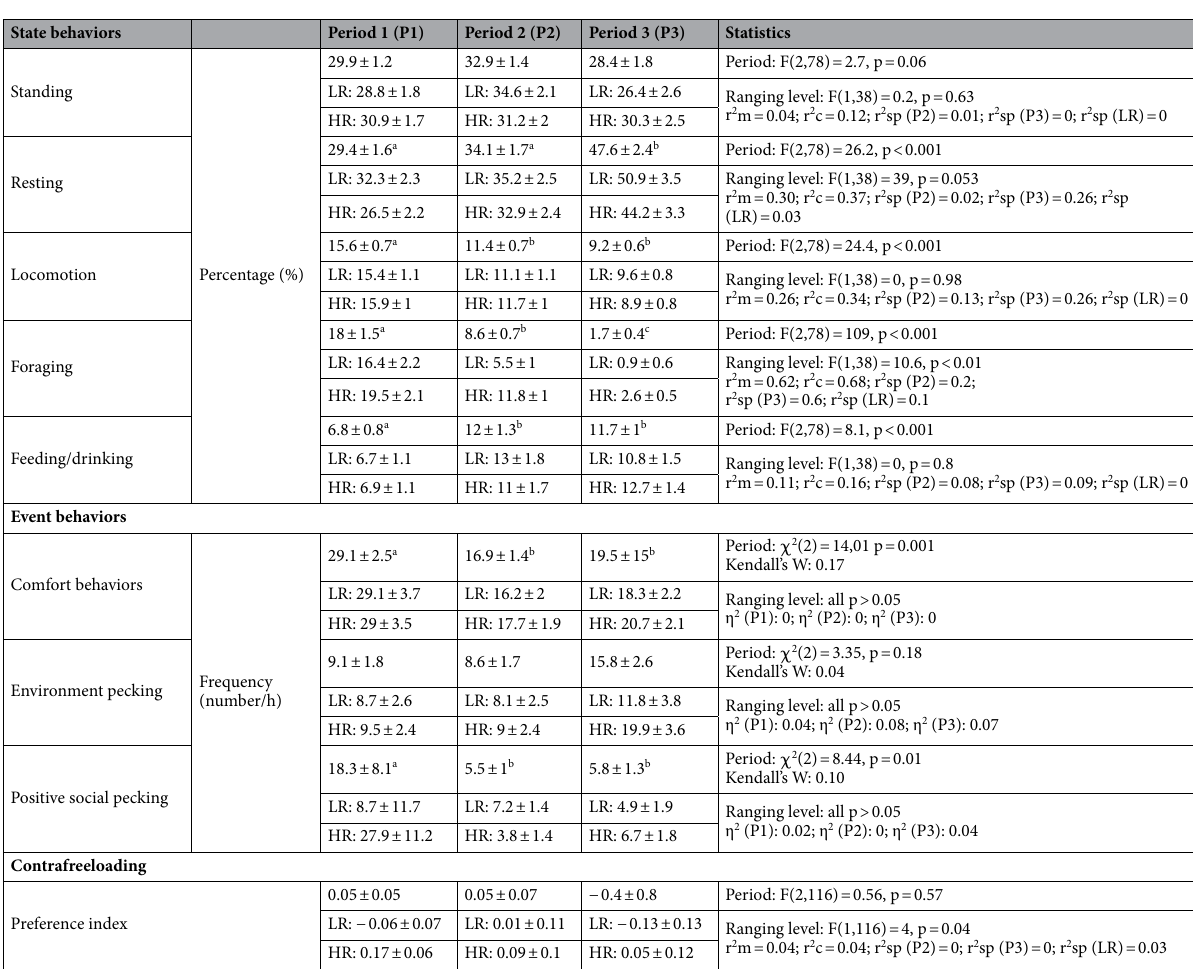
Table 2. Mean ± standard errors of state and event behaviors, on average, over the 3 periods (N = 40) or separately for low rangers (LR, N = 19) and high rangers (HR, N = 21). p-values (State behaviors and contrafreeloading: LMM Test; Event behaviors: Wilcoxon matched-pairs and Mann–Whitney U tests) and test statisticsa for all recorded behaviors. None of the interactions between fixed factors were significant and were excluded from the final models. r 2 m, r 2 c, and r 2 sp indicate the marginal, the conditional, and the semi-partial r-squared values, respectively, while η 2 corresponds to the eta-squared values. a Different superscript indicate significant differences between